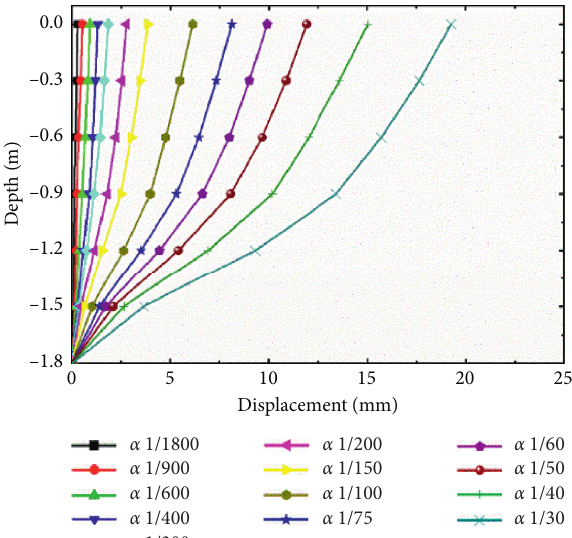
Figure 14: Horizontal displacement of soil.